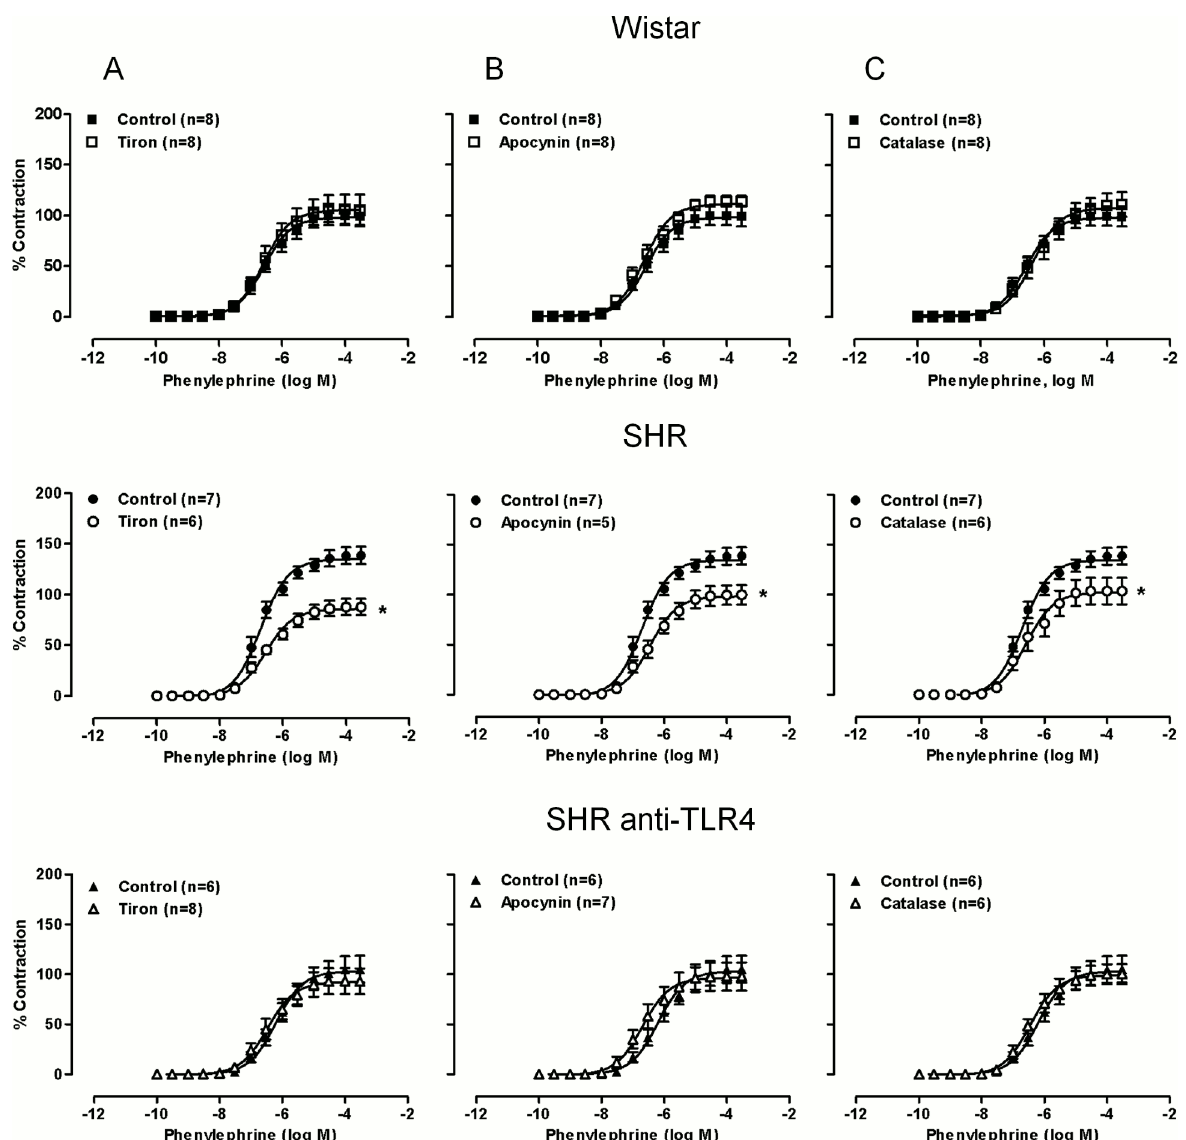
Figure 5. TLR4 inhibition abolishes the inhibitory effect of antioxidants on phenylephrine-induced contraction. Concentration- response curves to phenylephrine in aortic segments from Wistar and SHRs treated with a non-specific IgG (1 m g/day, 15 days) and SHRs treated with anti-TLR4 antibody (1 m g/day, 15 days) in the absence and presence of (A) tiron (1 m M), (B) apocynin (30 m M) and (C) catalase (1000 U/ml). Control curves were the same in the different situation of the three experimental groups. The results are the mean 6 SEM. *P , 0.05 vs. SHR using two-way ANOVA and Bonferroni post-test. The number of animals used is shown in parentheses.